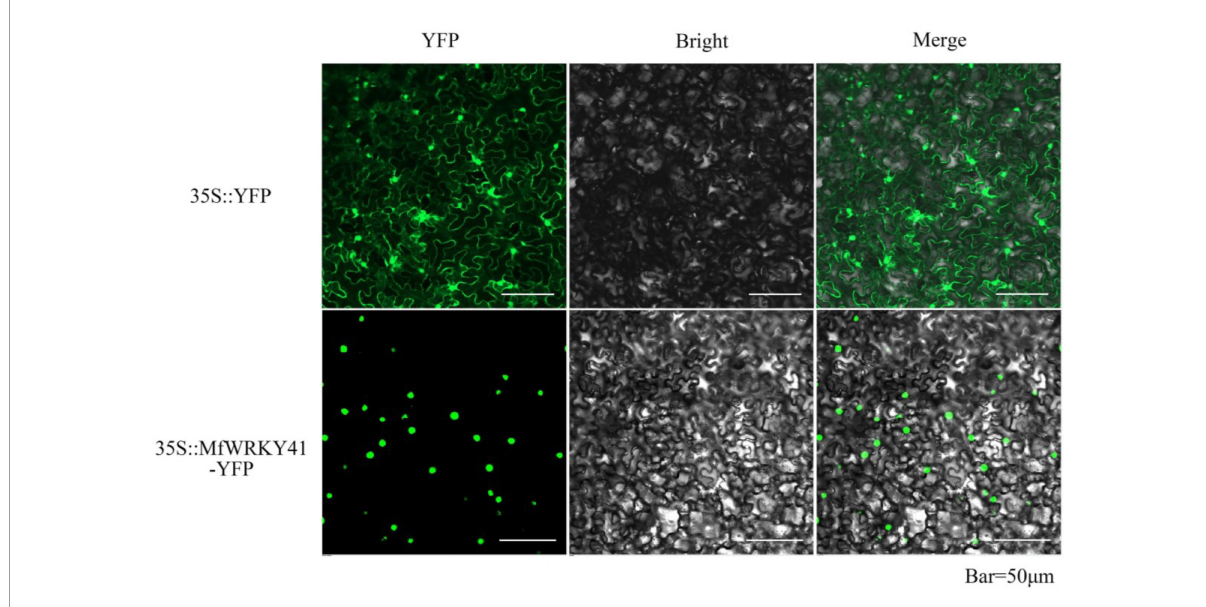
FIGURE2 Subcellular localization of MfWRKY41 in tobacco epidermis. Fluorescence detection of MfWRKY41-YFP fusion protein in tobacco leaf epidermal cells, and tobacco epidermis transformed with 35S: YFP was used as a control (upper lane).